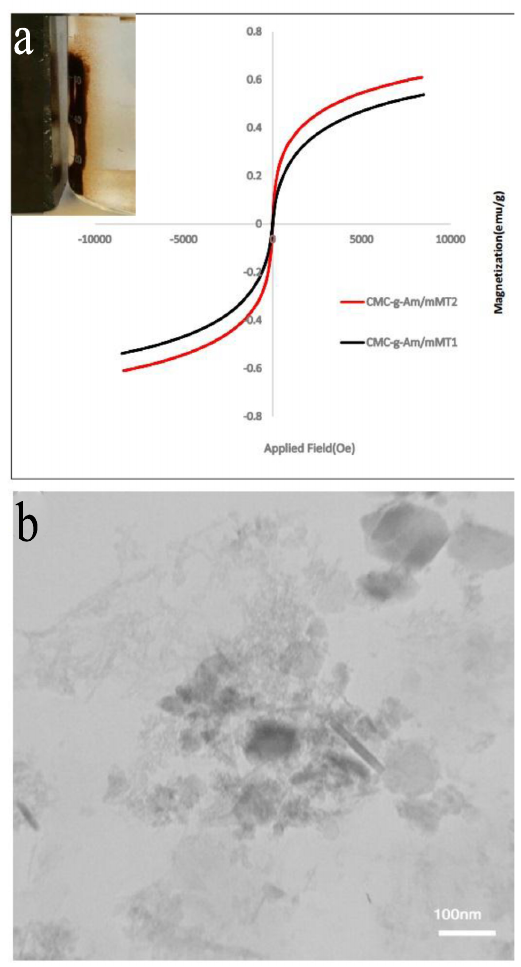
Fig. 4. (a) Swelling kinetic of hydrogels in distilled water. (b) Effect of pH on swelling degree of